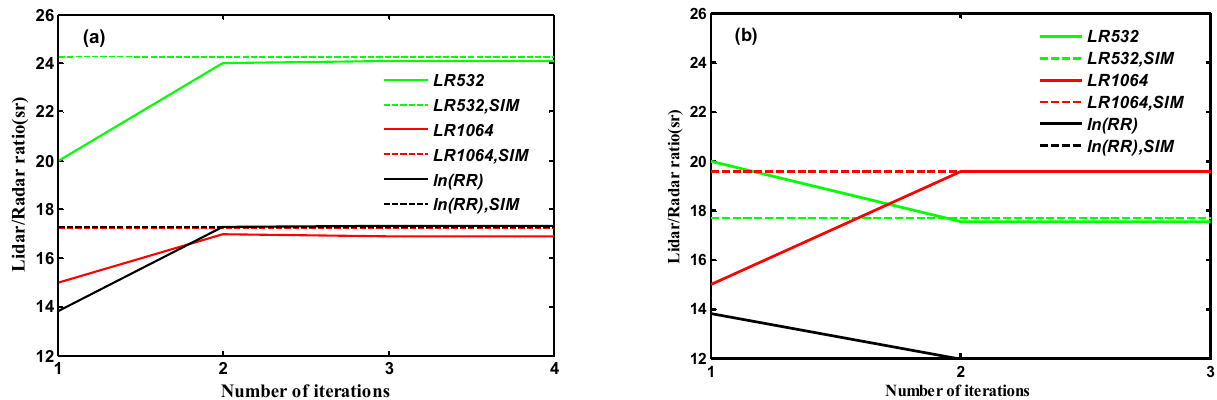
Figure 6. The iteration results for the lidar ratio (LR)/radar ratio ( RR ) at a fixed altitude. The ln( RR ) indicates the natural logarithm of RR . The inversion (solid line) and the simulated value (SIM, dash line) results assumed the median diameter ( D log ) and the width of the distribution ( σ ): ( a ) D log = 7.7 μ m, σ = 0.38; ( b ) D log = 35 μ m, σ = 0.4.